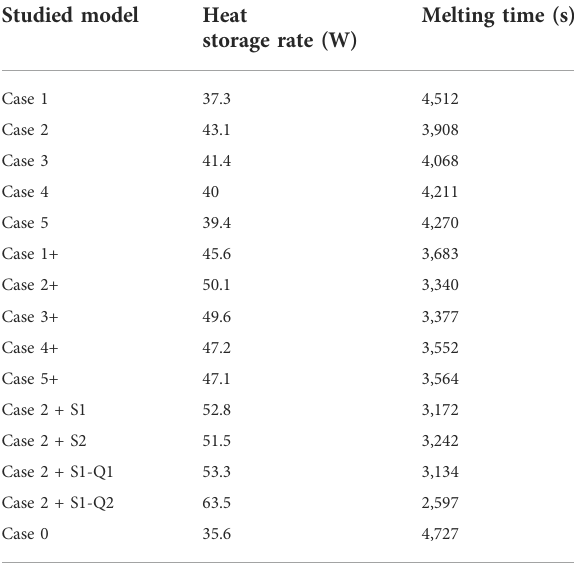
TABLE 4 Heat storage rate and the melting time of the PCM for different cases studied. Studied